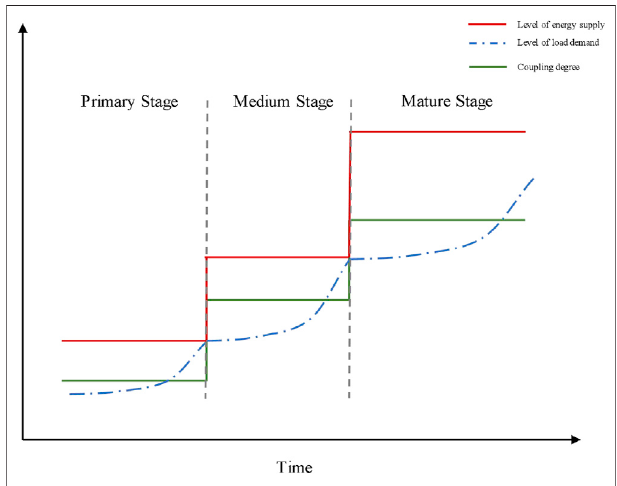
FIGURE 2 | Schematic diagram of the development stages of the